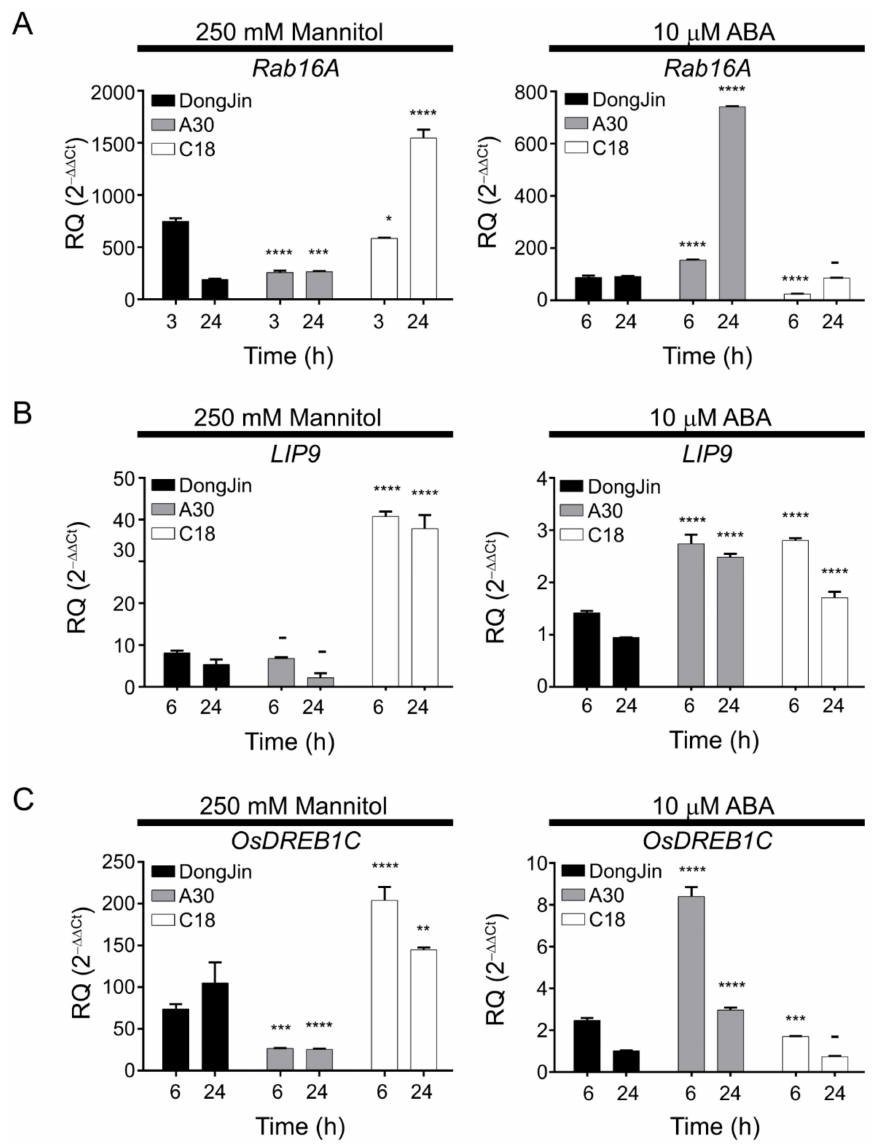
Figure 6. RT-qPCR analysis of three marker genes Rab16A , LIP9 , and OsDREB1C in DJ, A30 or C18 seedlings after exposure to 250 mM mannitol or 10 µ M ABA. Relative transcript levels of Rab16A ( A ), LIP9 ( B ) or OsDREB1C ( C ), determined by RT-qPCR and normalized to UBIQUITIN5 as internal control. Two-way ANOVAs were performed (****: p < 0.0001, ***: p < 0.001, **: p < 0.01, *: p < 0.05, -: not significant). Values are means ± SD ( n = 3). Similar results were obtained in three replicate